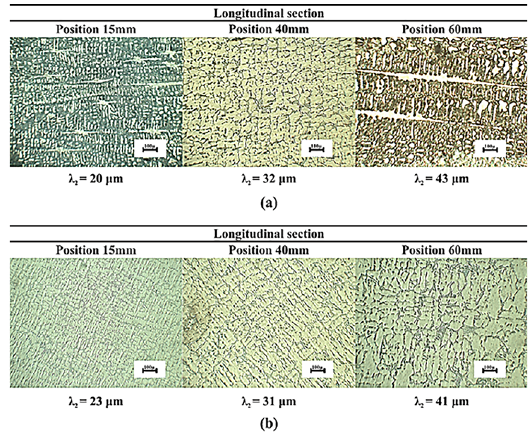
Figure 5. Revealed micrographs of the investigated alloy, showing the dendritic microstructures of the samples: (a) as-cast and (b) heat-treated